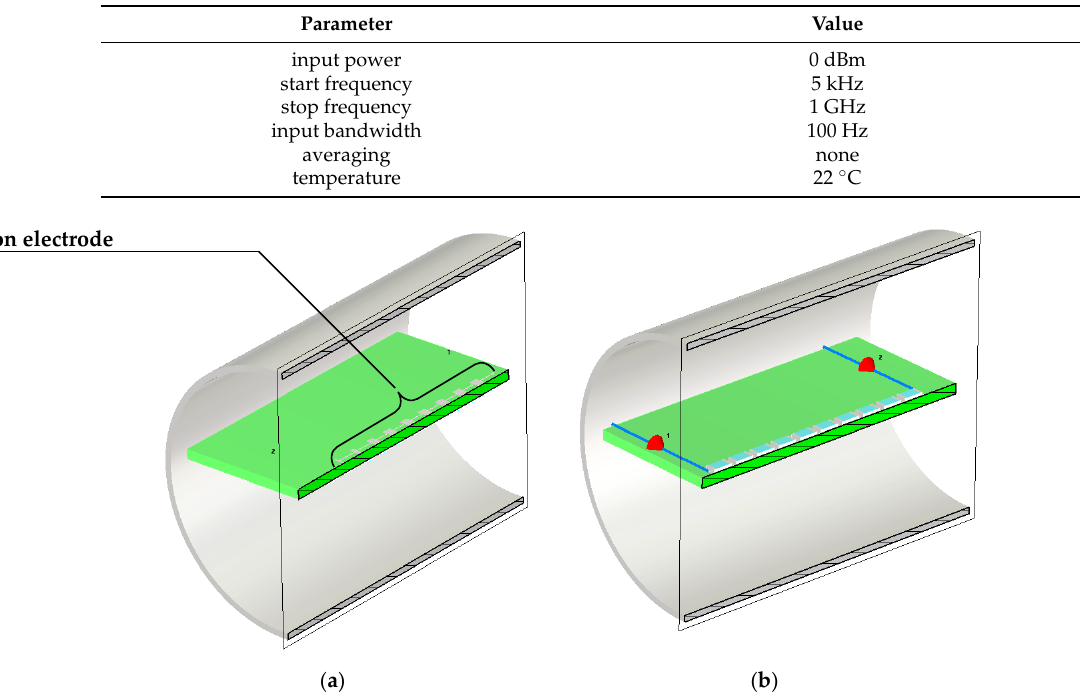
Figure A1. Simulation model for the impedance of the HVA consisting of ten resistors, the compensation electrode on the adjacent side, and the metallic enclosure in the Dassault Systémes CST Studio Suite 2021 ® Microwaves and RF solver: ( a ) bottom side with compensation electrode and ( b ) top side with ten HVA resistors.